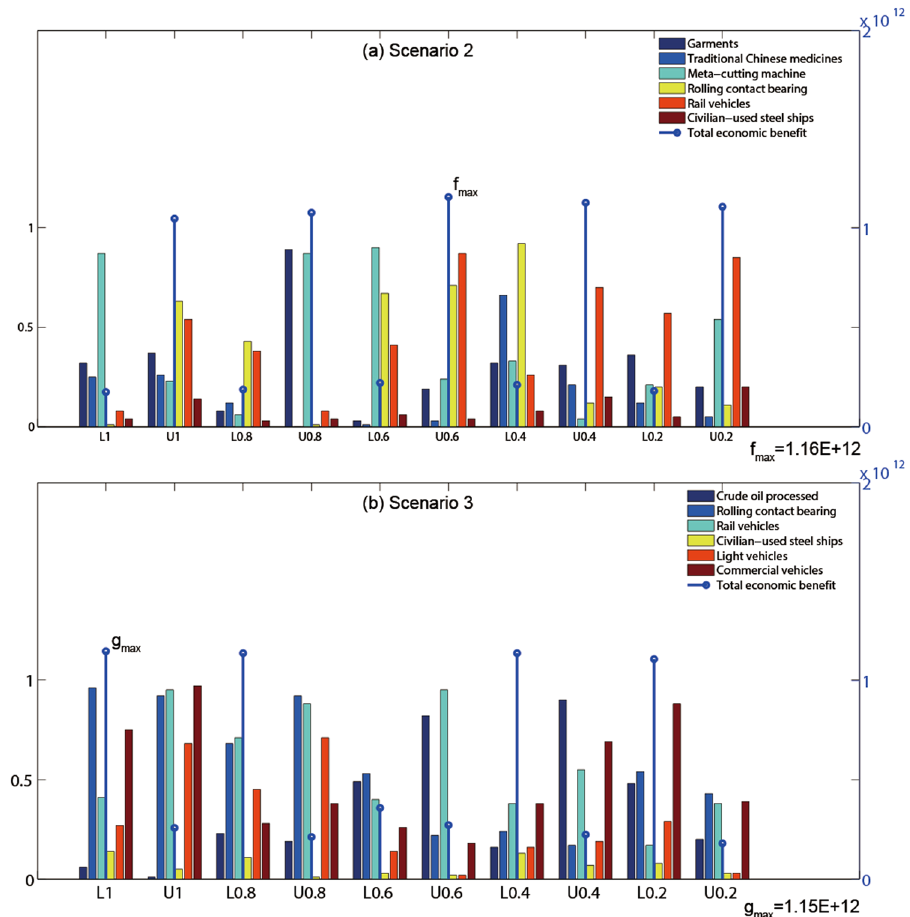
Figure 4. Planning modifications in scenarios 1 and 2. The letter of “L” represents the lower bound of interval numbers. The letter of “U” represents the upper bound of interval numbers. The numbers after the letters “L” and “U” are the multiple α -cut levels.